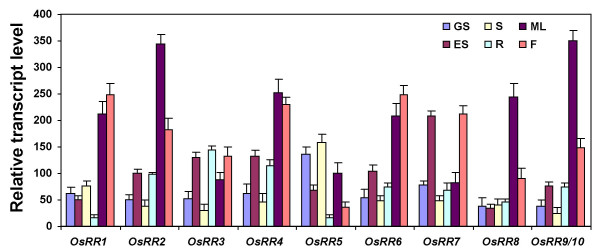
Real-time PCR analysis showing the organ-specific expression profiles of individual OsRR genes. The relative mRNA levels of individual OsRR genes normalized with respect to housekeeping gene, UBQ5, in different tissues (GS, green seedlings; ES, etiolated seedlings; S, green shoots; R, roots; ML, mature leaves; F, flowers) are presented.